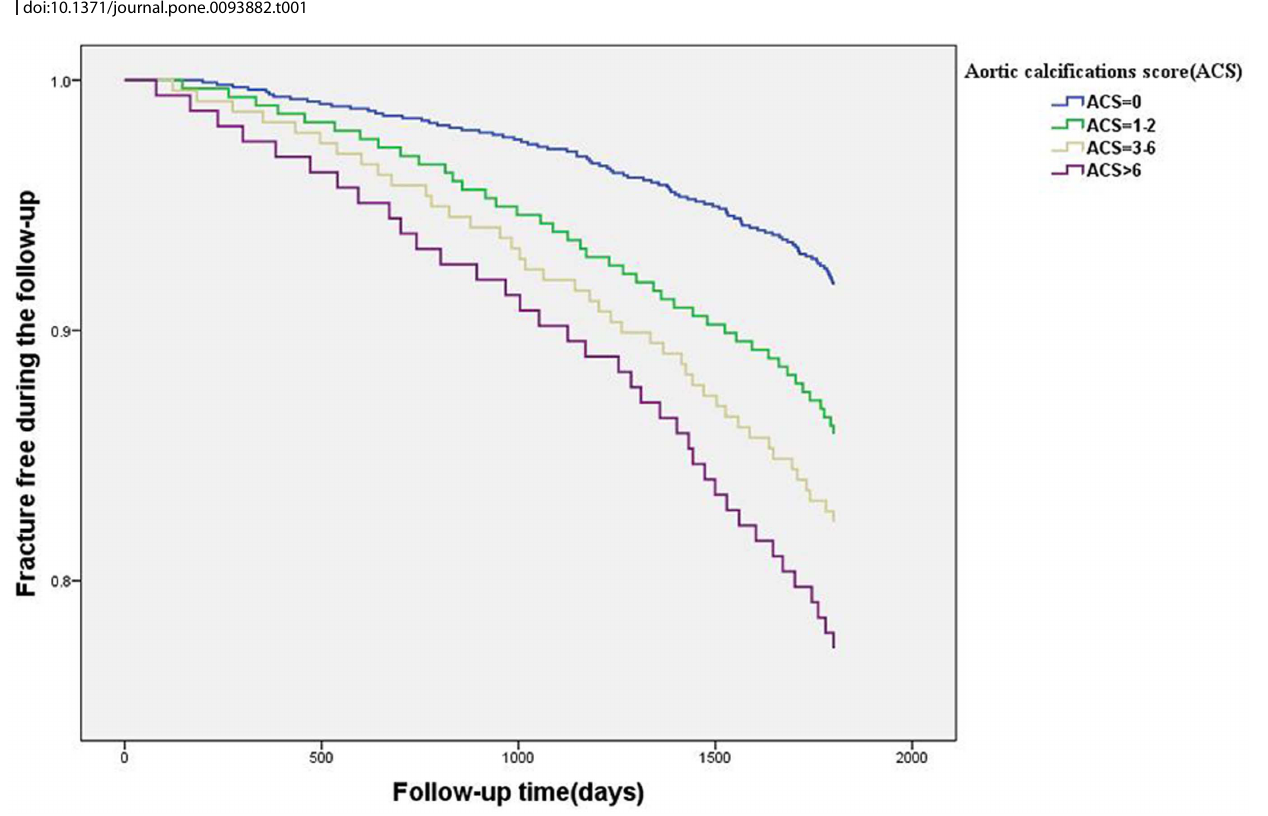
Figure 1. Fracture-free survival according to baseline ACS. Survival of women in this study cohort during over 5 years of follow-up, according to the ACS at baseline: ACS in G1 (0), G2 (1–2), G3 (3–6), and G4( . 6). Fracture incidence was significantly higher in G2, G3, and G4, compared to G1, at the end of the 5 years of follow-up (p , 0.001, respectively).